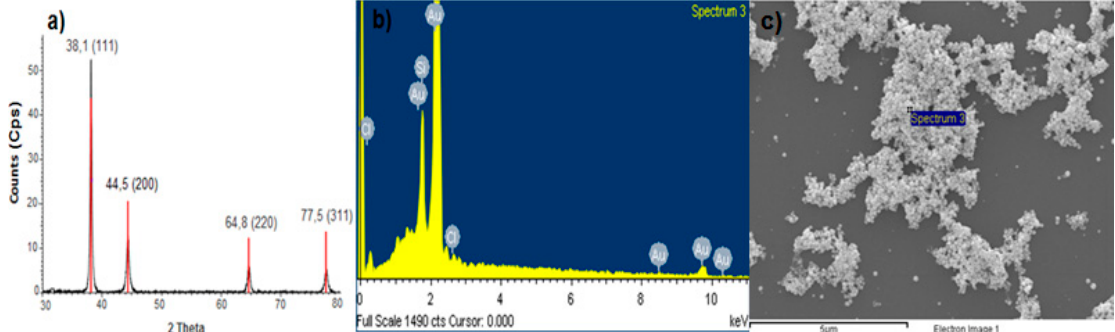
Figure 5. (a) XRD spectra of AuNSps, (b) EDX spectra and (c) SEM image of AuNSps coated glass.